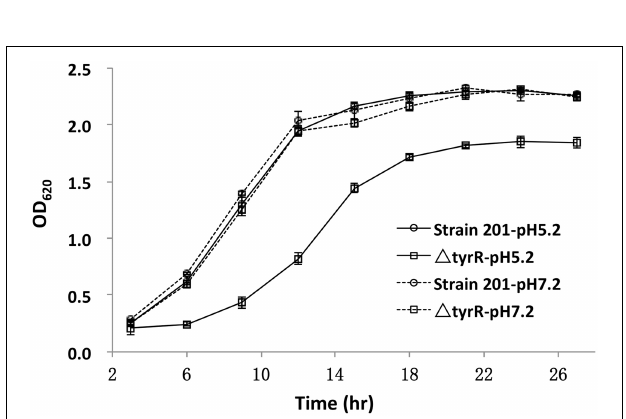
FIGURE 2 | Growth curves of the WT and tyrR mutant strains under two different conditions. Overnight cultures of the WT strain 201 and tyrR mutant were used to inoculate fresh LB broth with pH 5.2 or 7.0. The OD 620 values were recorded at fixed time points. Each time point is the average of two measurements and error bars represent standard deviations. The vertical arrows indicate the time point at which samples were removed for RNA extraction.